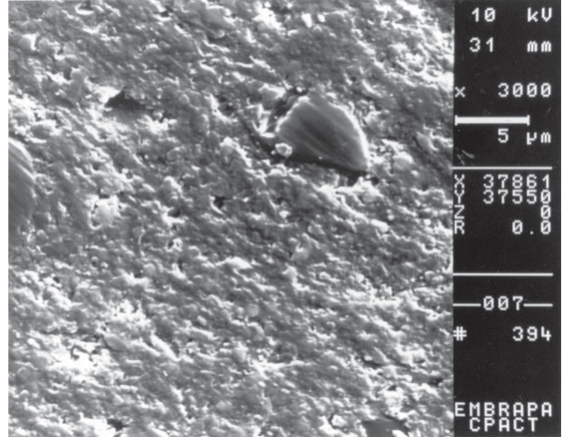
Figure 3. SEM micrography of Artglass surface at aging time 0 (SEM original magnification 10000 ×